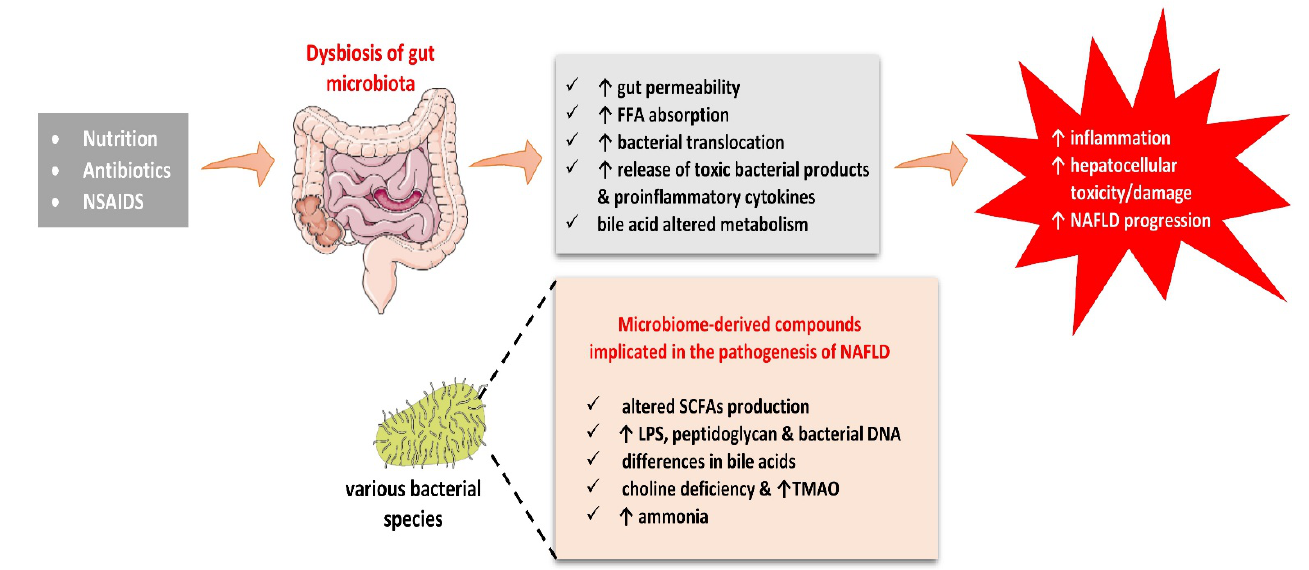
Figure 3. Dysbiosis of gut microbiota may explain the inflammatory process and hepatotoxicity of microbiome-derived compounds implicated in the pathogenesis of NAFLD. Abbreviations: FFA, Free Fatty Acids; LPS, Lipopolysaccharide; NAFLD, Non-Alcoholic Fatty Liver Disease; NSAIDs, Non-Steroid Anti-Inflammatory Drugs; SCFAs, Short-chain Fatty Acids; TMAO, Trimethylamine N- oxide. (All images are originated from the free medical website http://smart.servier.com/ by